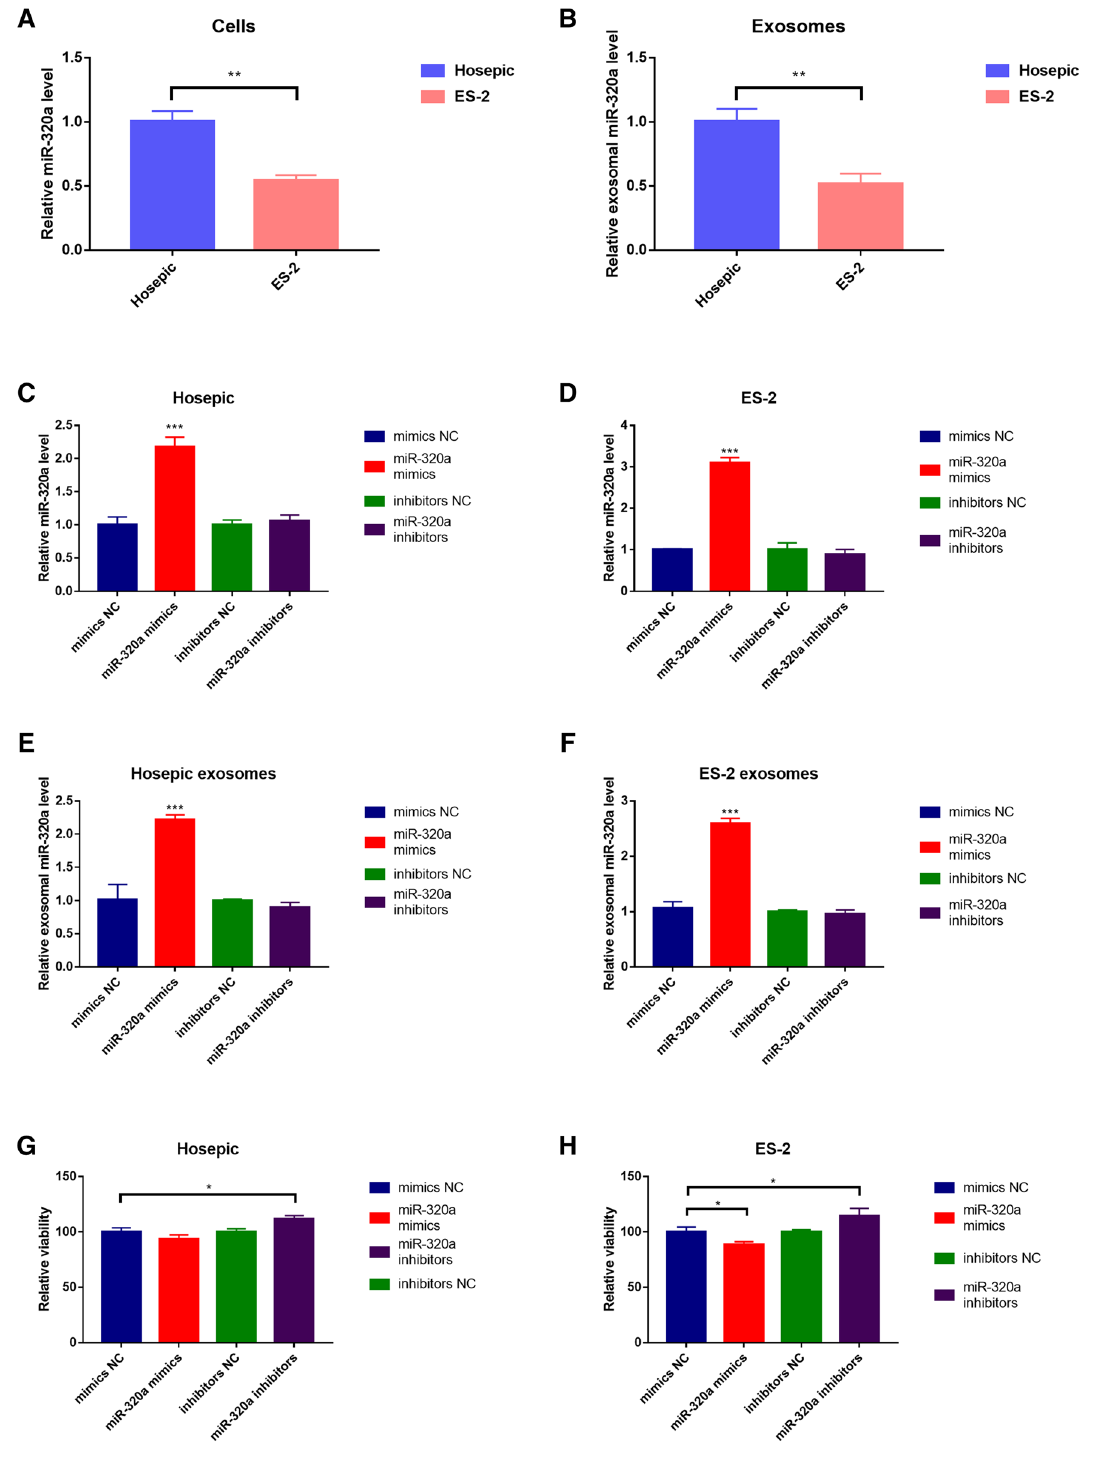
Fig. 4 Characterization of miR-320a expression in cells and their corresponding EVs. A miR-320a expression in Hosepic and ES-2 cells. B miR- 320a expression in EVs derived from Hosepic and ES-2 cells. C The effect of mimics NC, miR-320a mimics, inhibitors NC, and miR-320a inhibi- tors on miR-320a expression in Hosepic cells. D The effect of mimics NC, miR-320a mimics, inhibitors NC, and miR-320a inhibitors on miR- 320a expression in ES-2 cells. E The effect of mimics NC, miR-320a mimics, inhibitors NC, and miR-320a inhibitors on miR-320a expression in EVs derived from Hosepic cells. F The effect of mimics NC, miR-320a mimics, inhibitors NC, and miR320a inhibitors on miR-320a expression in EVs derived from ES-2 cells. G The effect of mimics NC, miR-320a mimics, inhibitors NC, and miR-320a inhibitors on cell viability in Hosepic cells. H The effect of mimics NC, miR-320a mimics, inhibitors NC, and miR-320a inhibitors on cell viability in ES-2